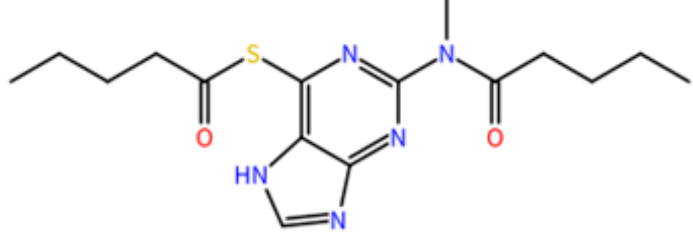
Figure 9. Structure of matrix compound